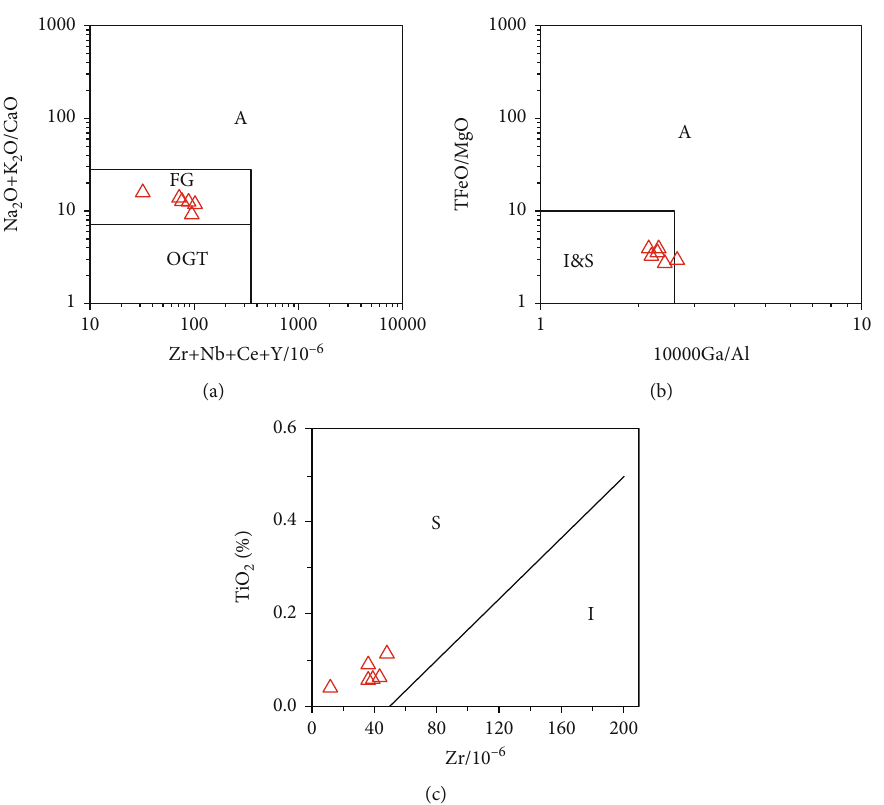
Figure 6: Discrimination diagrams of granite genetic types for the Bieyesamas monzogranite. (a) ð Zr + Nb + Ce + Y Þ vs. ðð K CaO Þ diagram (after [36]), (b) 10000Ga/Al vs. (TFeO/MgO)diagram (after [39]), and (c) Zr vs. TiO granite, OGT-unfractionated I-, S-type